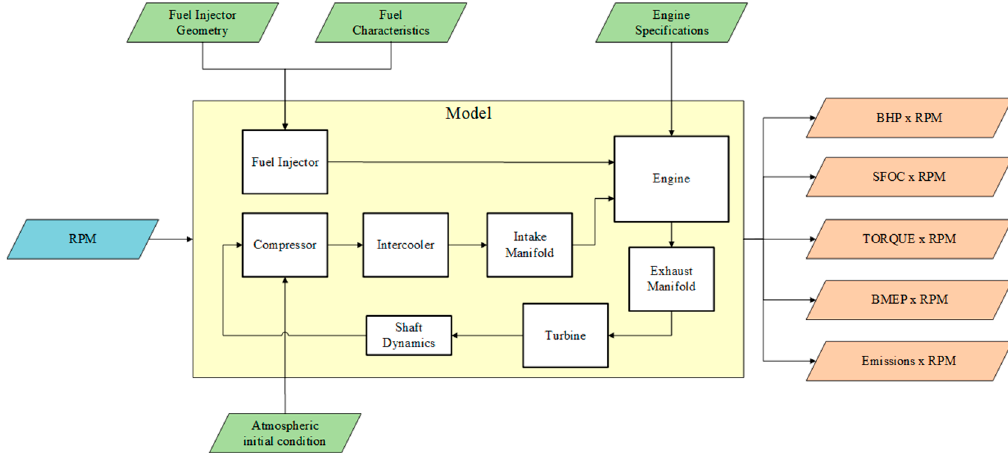
Figure 4. Schematic diagram of the engine model reproduced from [6], with permission from CRC Press, 2020.